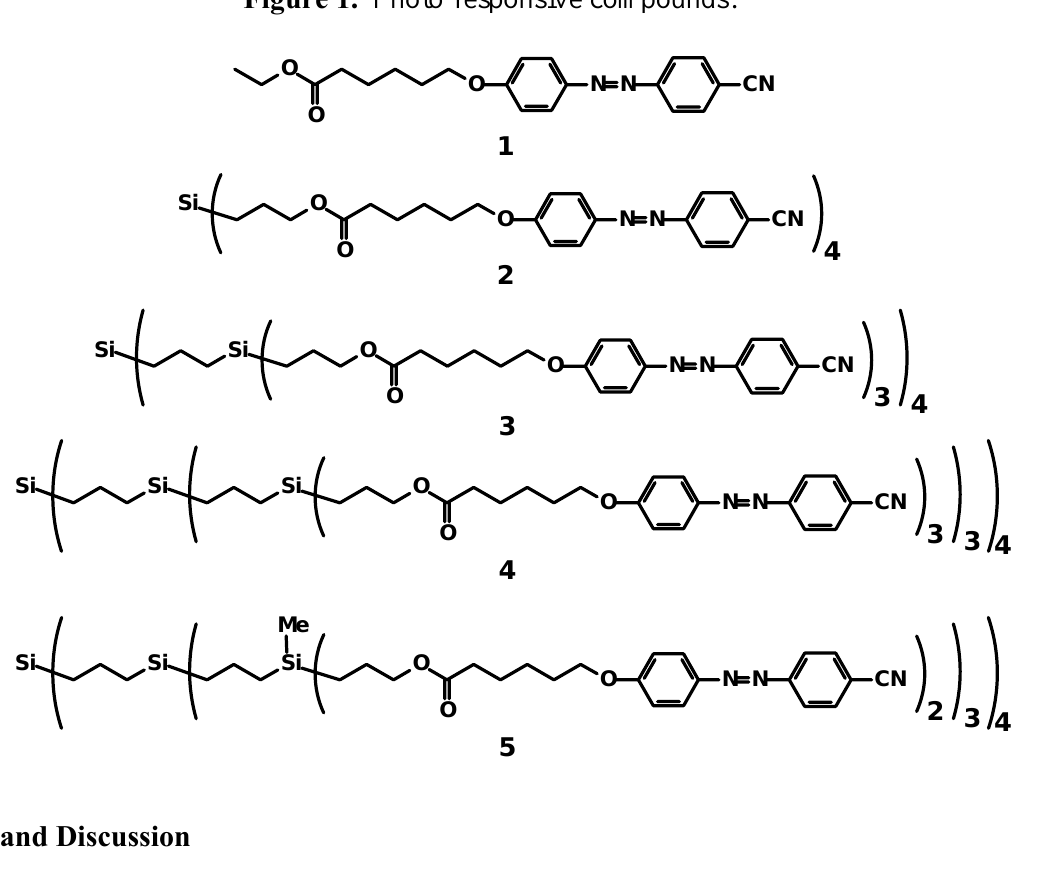
Figure 1. Photo-responsive